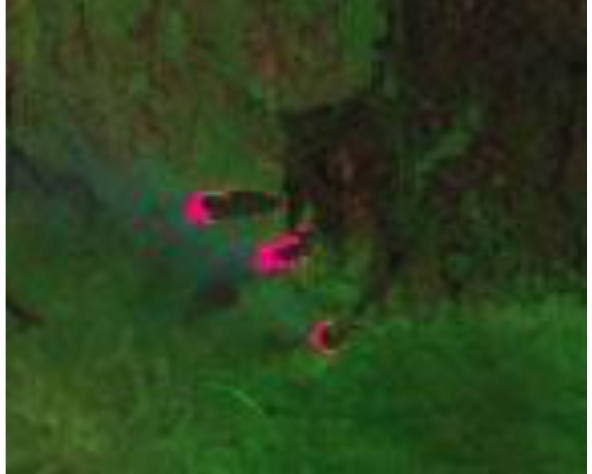
Figure 7. Real-time generated fire mask for the above image (shown in pink) Figure 6 and Figure 7 show bush fires over southern Tanzania with and without the generated fire mask.